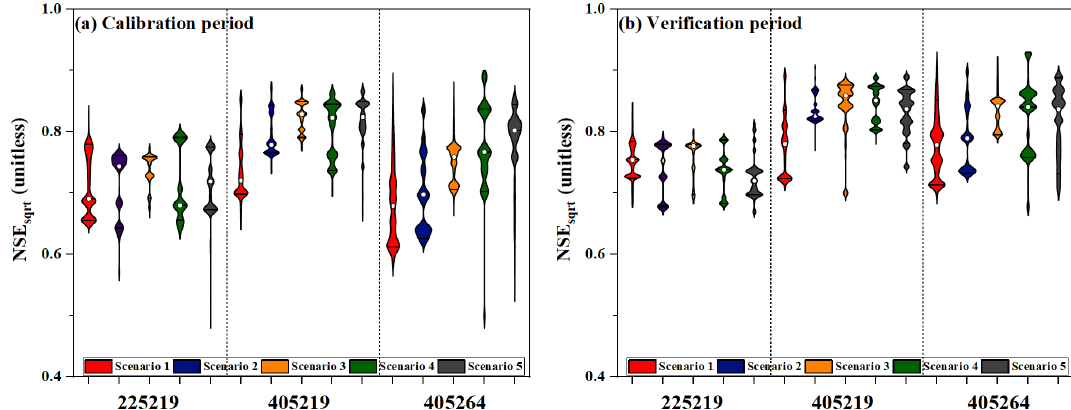
Figure 6. NSE sqrt for each of the five scenarios for each catchment during (a) the calibration period (dry years) and (b) the verification period (wet years). The white dots represent the median estimates of the